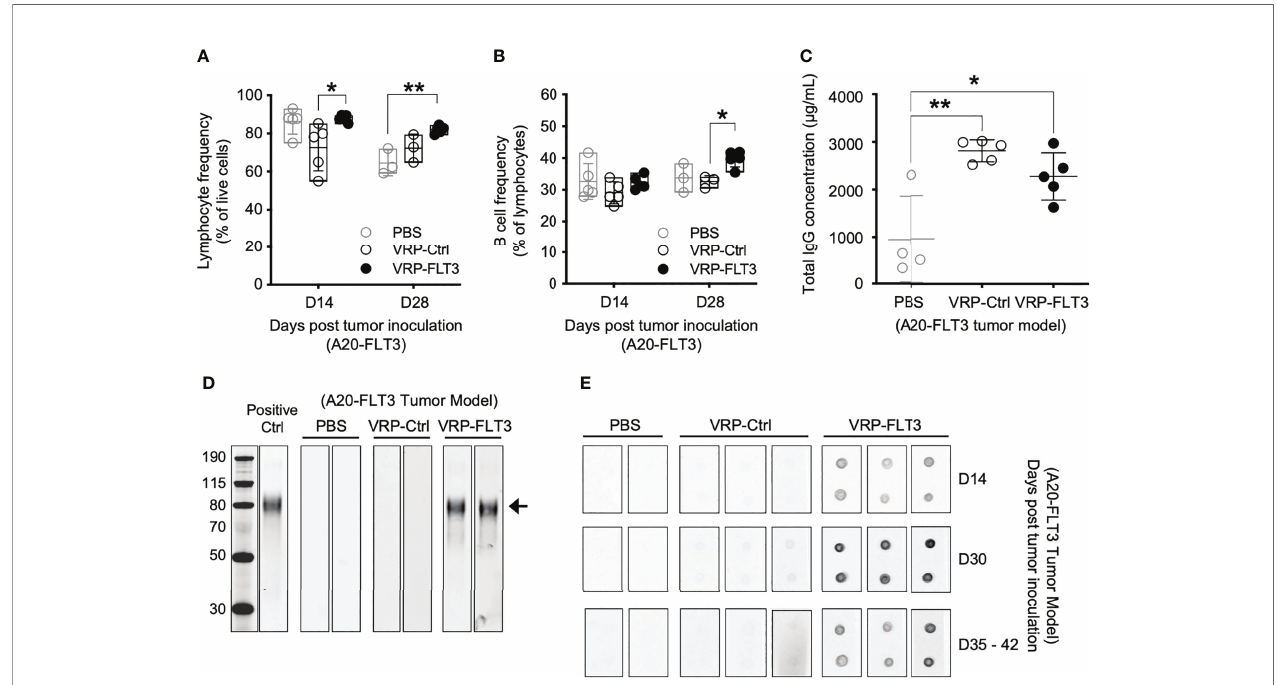
FIGURE 2 | VRP-FLT3 vaccination elicits a FLT3-speci fi c antibody response in a mouse lymphoma model. Mice challenged with A20-FLT3 tumor cells were vaccinated as described in Figure 1 . (A, B) Blood samples harvested on days 14 and 28 were analyzed by fl ow cytometry for the frequencies of (A) lymphocytes and (B) CD19 + B cells. (C) Concentrations of total IgG in plasma on day 28 were determined by ELISA. Each symbol represents an individual mouse (n=5 per group). Bars represent the mean ± SD. Statistical signi fi cance was determined by one-way ANOVA, *P<0.05, **P<0.01. (D) Western blot of recombinant mouse FLT3 protein. Plasma collected on days 35-42 was 1:250 diluted and used for probing. Arrow indicates the FLT3 protein. Two representative samples per group are shown. Positive Ctrl represents FLT3 detection with commercial anti-FLT3 antibody. Panel at left represents MWM, with numbers indicating kDa for the bands shown. (E) Dot blot of recombinant mouse FLT3 protein. Protein was spotted in duplicate and probed with 1:500 diluted plasma collected on indicated time points. Two to three representative samples per group are shown. In both (D, E) , fl uorochrome-conjugated anti-mouse IgG secondary antibody was used for signal